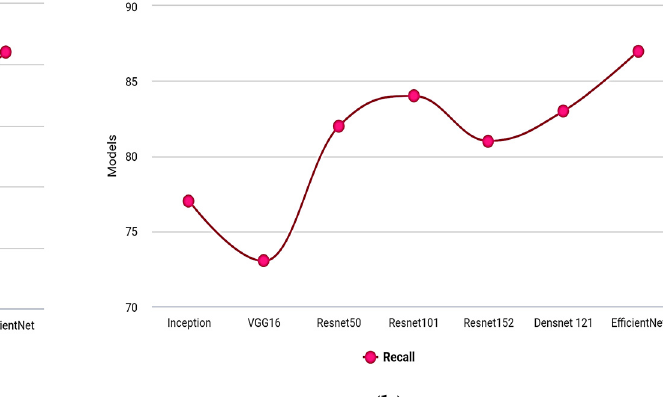
Table 6. Comparison analysis of the proposed model under Precision, Recall, and F1-score. Models